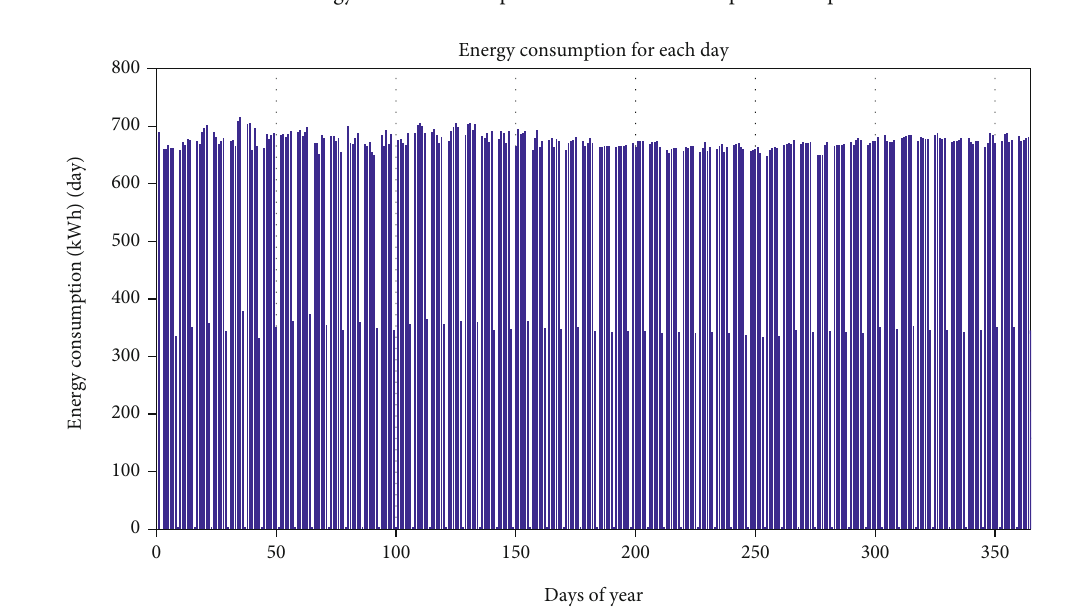
Figure 6: EnergyPlus simulation pro fi les and ANN model prediction pro fi les.